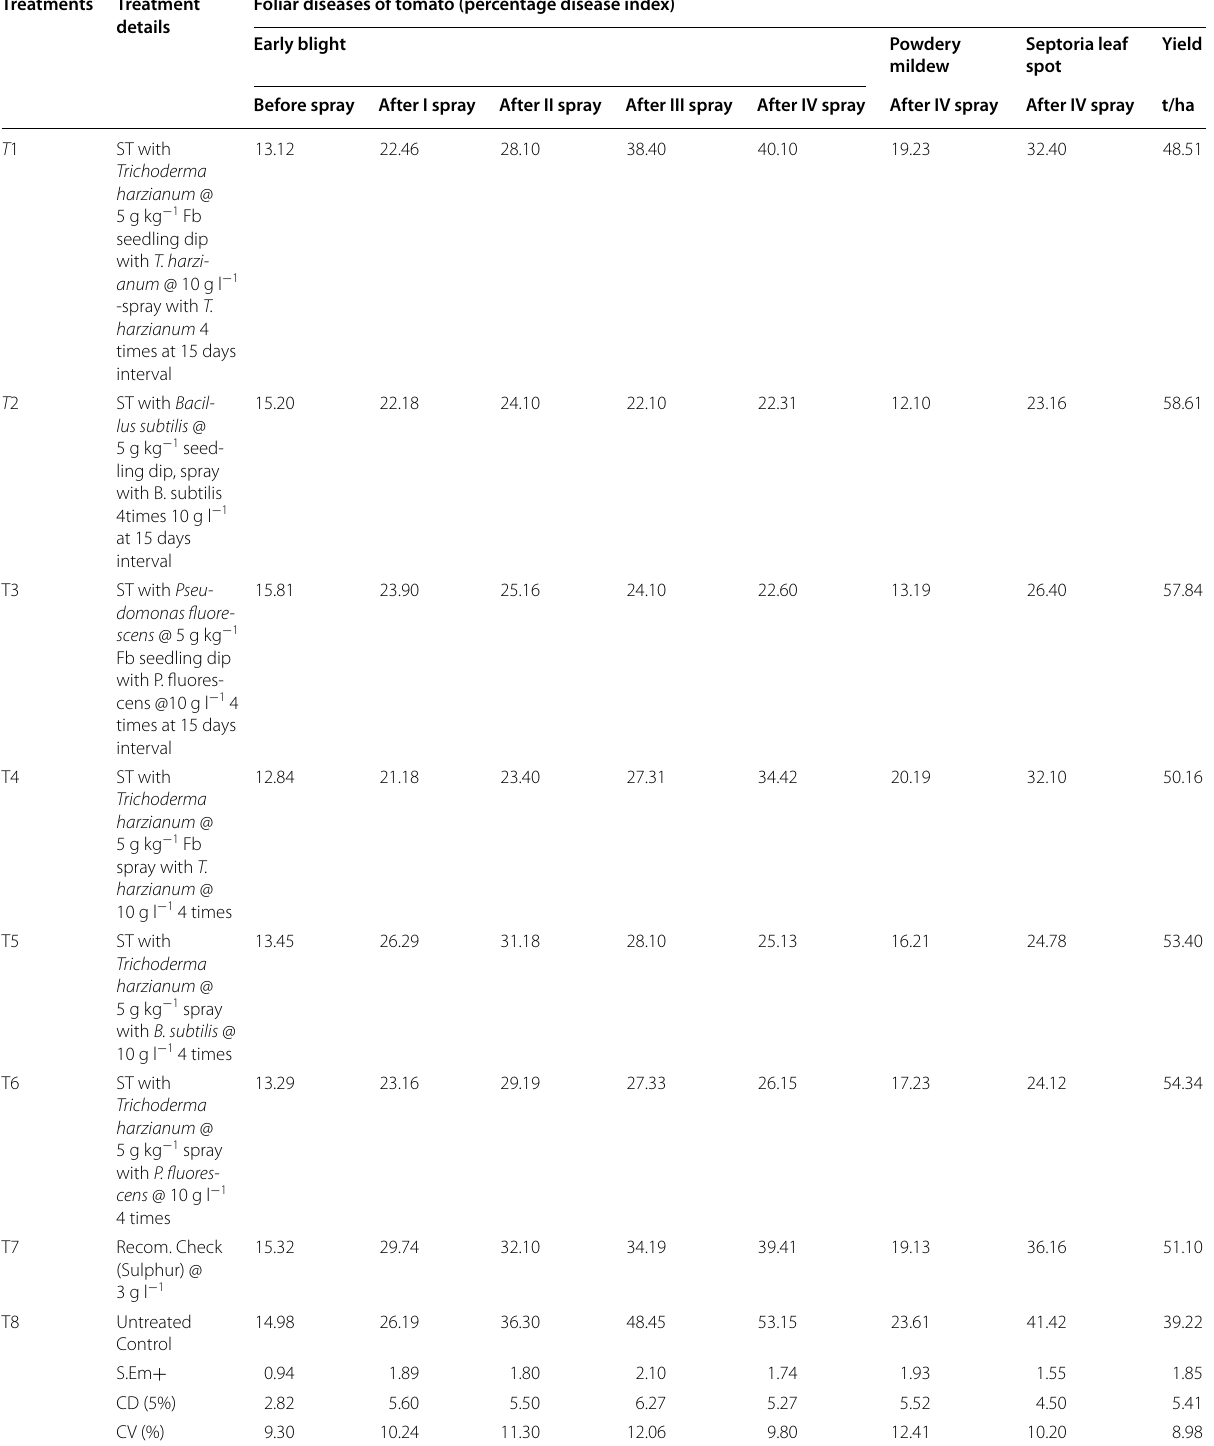
SEm standard error of mean, CD confidence distribution, CV coefficient of